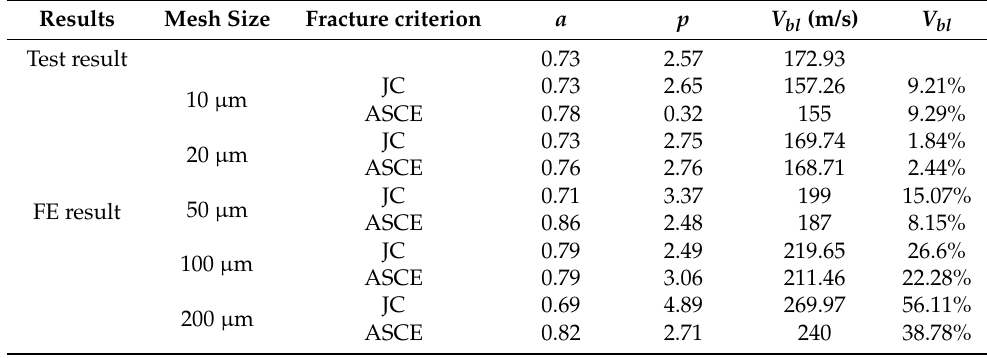
Table 4. Summary of BLVs and Recht–Ipson model parameters under different element sizes.